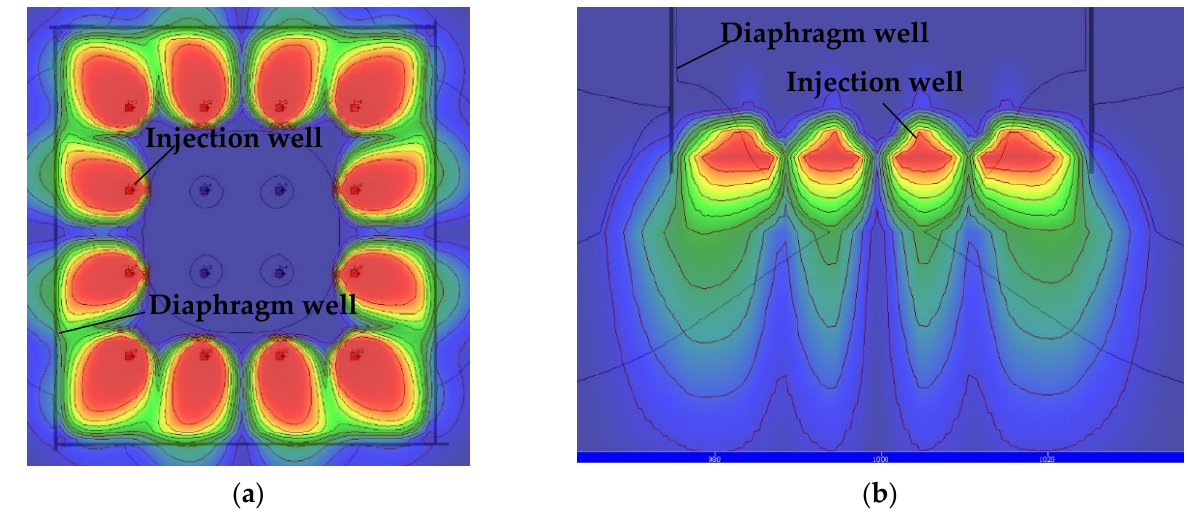
Figure 14. Migration of S. pasteurii after 4 days in condition 4: ( a ) Horizontal; ( b ) Vertical.